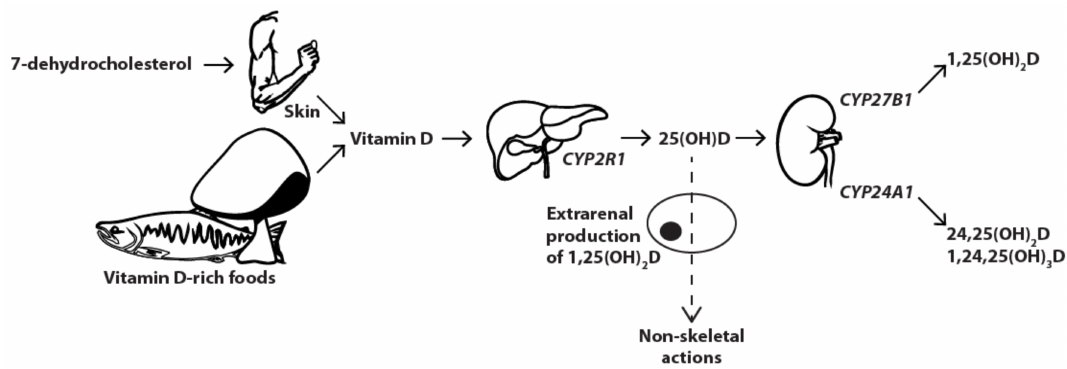
Figure 1. Vitamin D metabolism. From the production of vitamin D in the human skin or ingestion from certain vitamin D-rich foods to the final metabolisation into active (1,25(OH) 2 D) and largely inactive metabolites (24,25(OH) 2 D and 1,24,25(OH) 3 D). 25(OH)D: 25-hydroxyvitamin D; 1,25(OH) 2 D: 1,25-dihydroxyvitamin D; 24,25(OH) 2 D: 24,25-dihydroxyvitamin D; 1,24,25(OH) 3 D: 1,24,25-trihydroxyvitamin